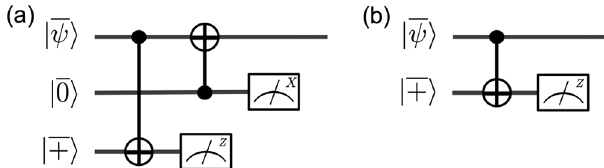
FIG. 10. (a) Measurement of the stabilizers of the 7-qubit code block j ¯ ψ i as put forward by Steane [28]. Gates and measurements are drawn to represent transversal versions. Both j verified logical states that we assume are created by Goto ’ s postselection [37] circuit with just 1 qubit for verification (so 8 qubits total), which has circuit volume 53. The total circuit volume of the complete Steane stabilizer measurement is 53 × 2 þ 49 ¼ 155 . (b) The measurement of just the Z stabilizers on the 7-qubit code using a verified j ¯ þi state. Total circuit volume is 81.